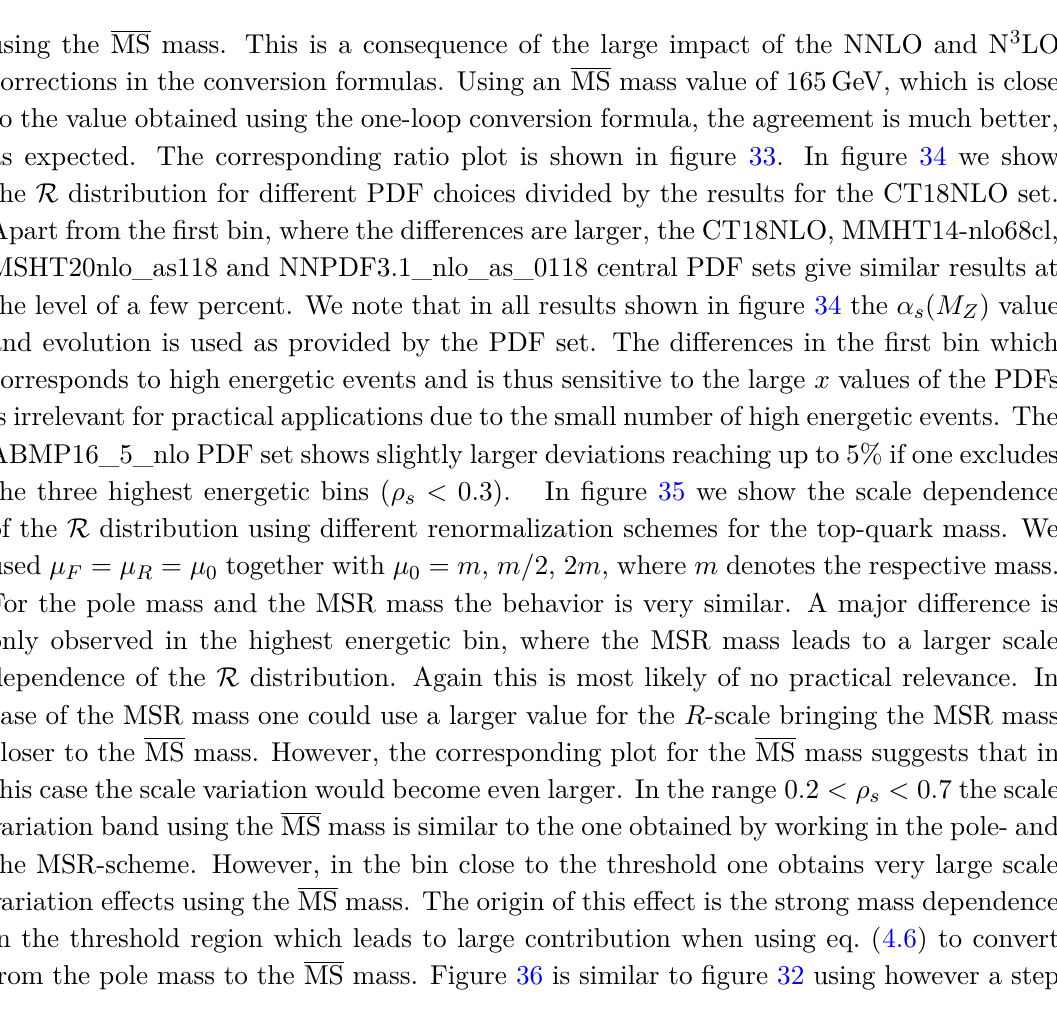
Figure 33 . Ratio of R in the MS and MSR scheme to R ref in the pole scheme, similar to the fourth plot in figure 32, however using m ( m ) = 165 GeV instead of 163